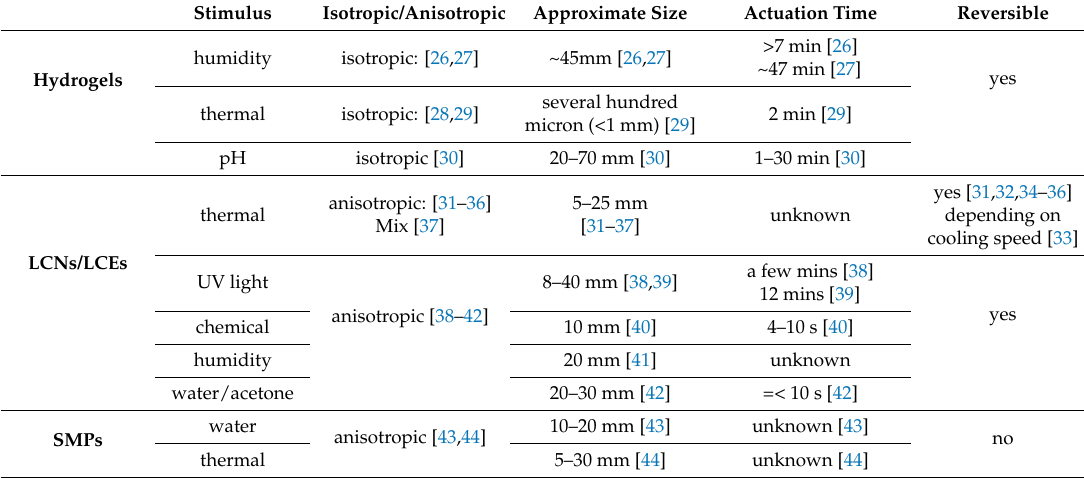
Table 1. Helical structures mimicking Bauhinia variegata based on hydrogels, liquid crystal networks/elastomers, and shape memory